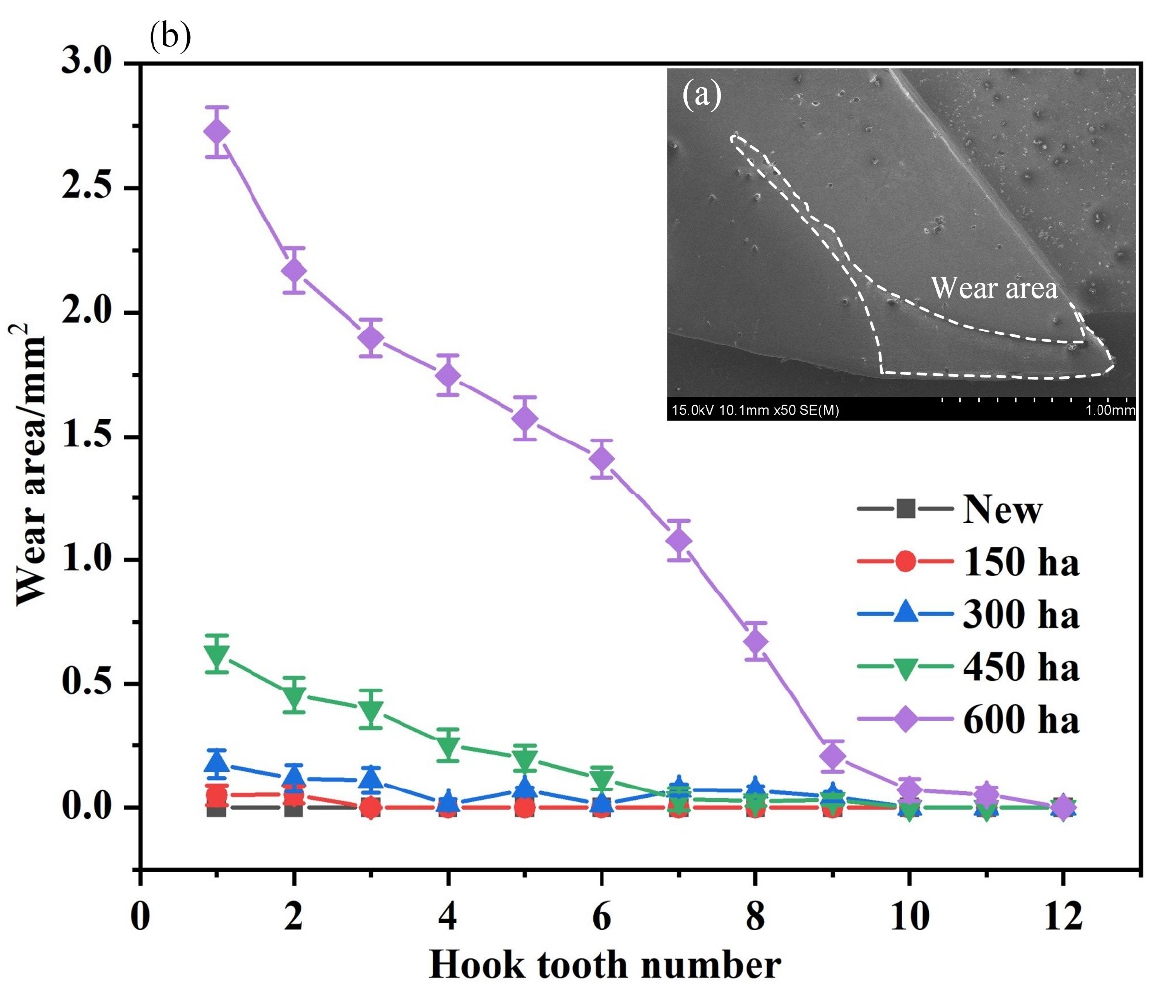
Coatings 2022 , 12 , 762 14 of 17